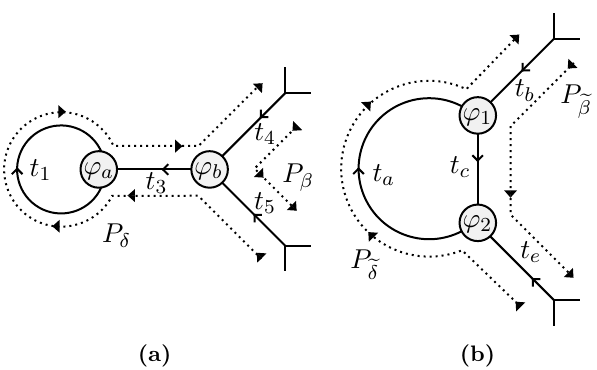
Figure 17. Two dual subgraphs in which a loop is involved in the